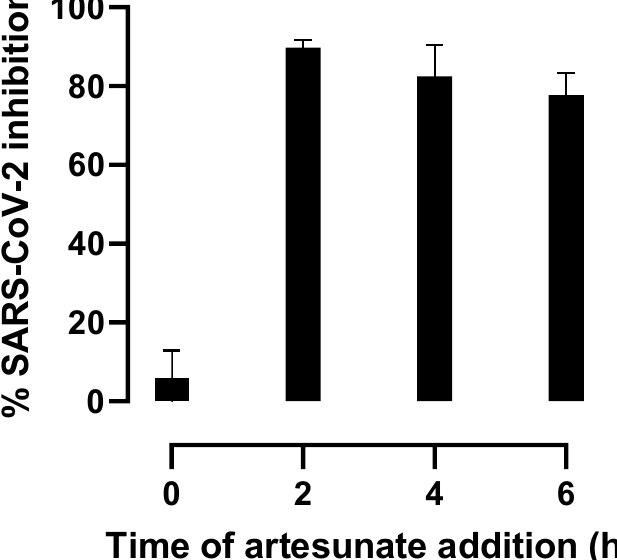
Figure 6. Time-of-artesunate-addition assay. A549-hACE2 cells were infected with SARS-CoV-2 for 2 h. Artesunate at 14 µg/mL was added at different time points after viral inoculation: 0 h, addition at the time of viral inoculation with presence of the drug during the 2 h viral infection phase; 2 h, addition 2 h post inoculation, immediately after the 2 h viral infection phase; 4 h and 6 h, addition 4 h and 6 h post inoculation, respectively. After a 2-day incubation, infected cells were visualized by immunostaining for SARS-CoV-2 spike glycoprotein and counted automatically as described in “Materials and methods”. % inhibition was calculated as (100%—% residual infectivity). % residual infectivity for individual wells was calculated by relating counts of infected treated wells to the mean count of 12 infected nontreated control wells. Datapoints (columns) are means of six replicates with